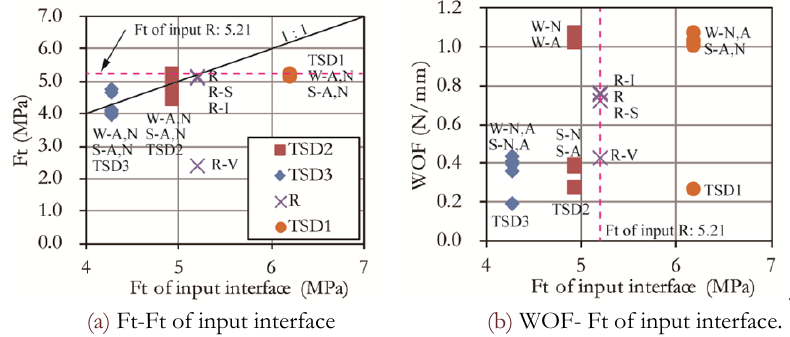
Figure 13: Relationship between Ft (or WOF) and Ft of interface for repaired